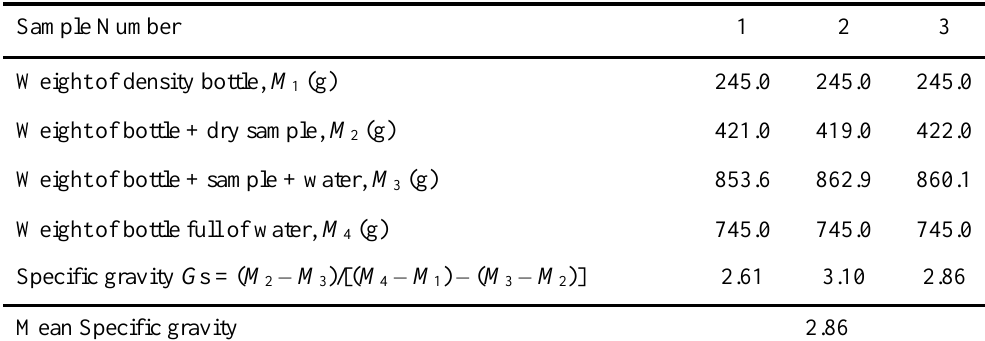
Table 5. Specific Gravity of Periwinkle Shell Ash (developed by the authors, based on the conducted